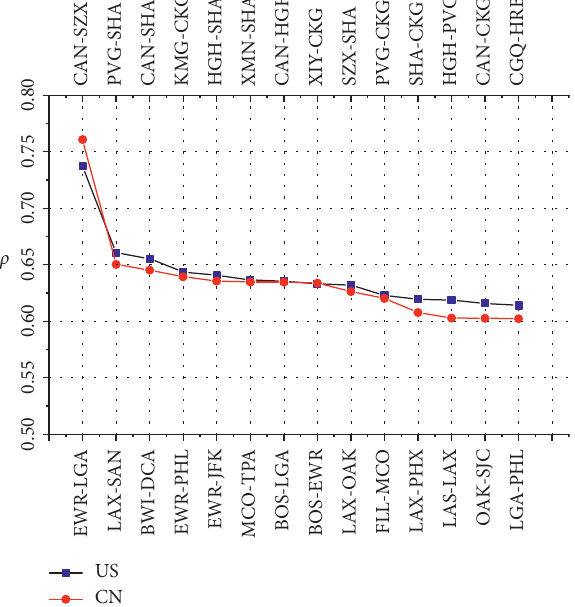
Figure 4: Correlation coefficients of airport